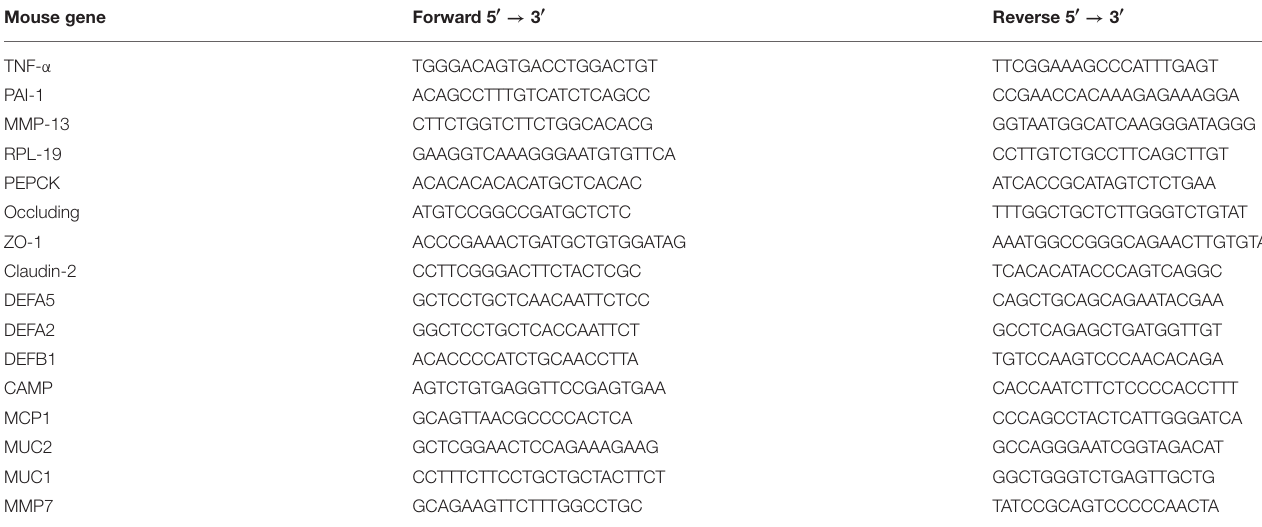
TABLE 3 | Primers used for RT-qPCR analysis. Mouse gene